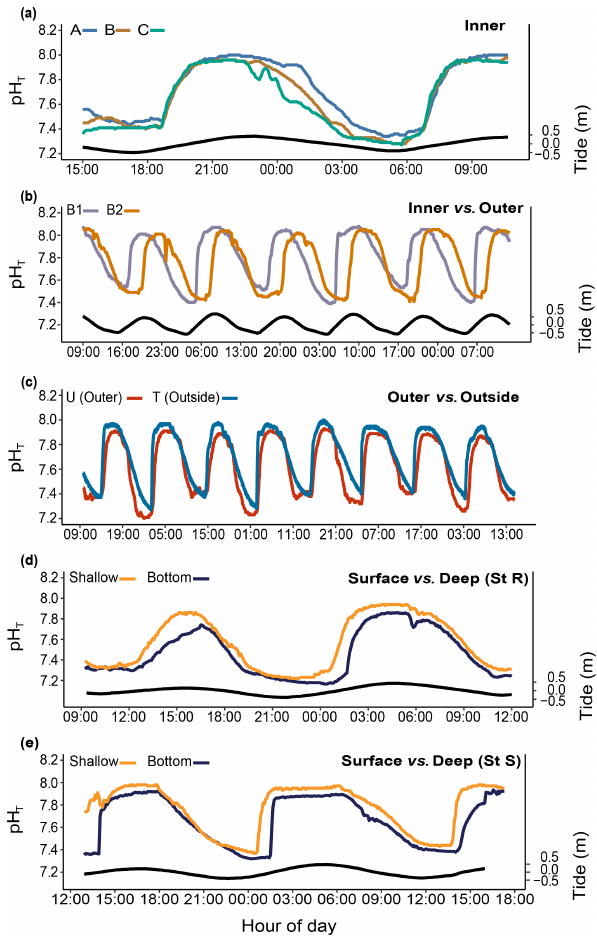
Figure 5. Spatial and depth-related short-term changes (24h) in pH T at stations in the Bouraké lagoon (see Fig. 1 for the station locations). Spatial variations were assessed (a) within the inner reef (Sts A–C); (b) between the inner and the outer reefs (Sts B1 and B2); (c) between the outer reef (but still inside the Bouraké lagoon) and the reef outside the semi-enclosed lagoon (St U vs. T). Depth- related variations were assessed between shallow reefs and the bot- tom of the channel (d) at the inner reef (St R) and (e) at the outer reef (St S). Tide (black line) refers to St B2.